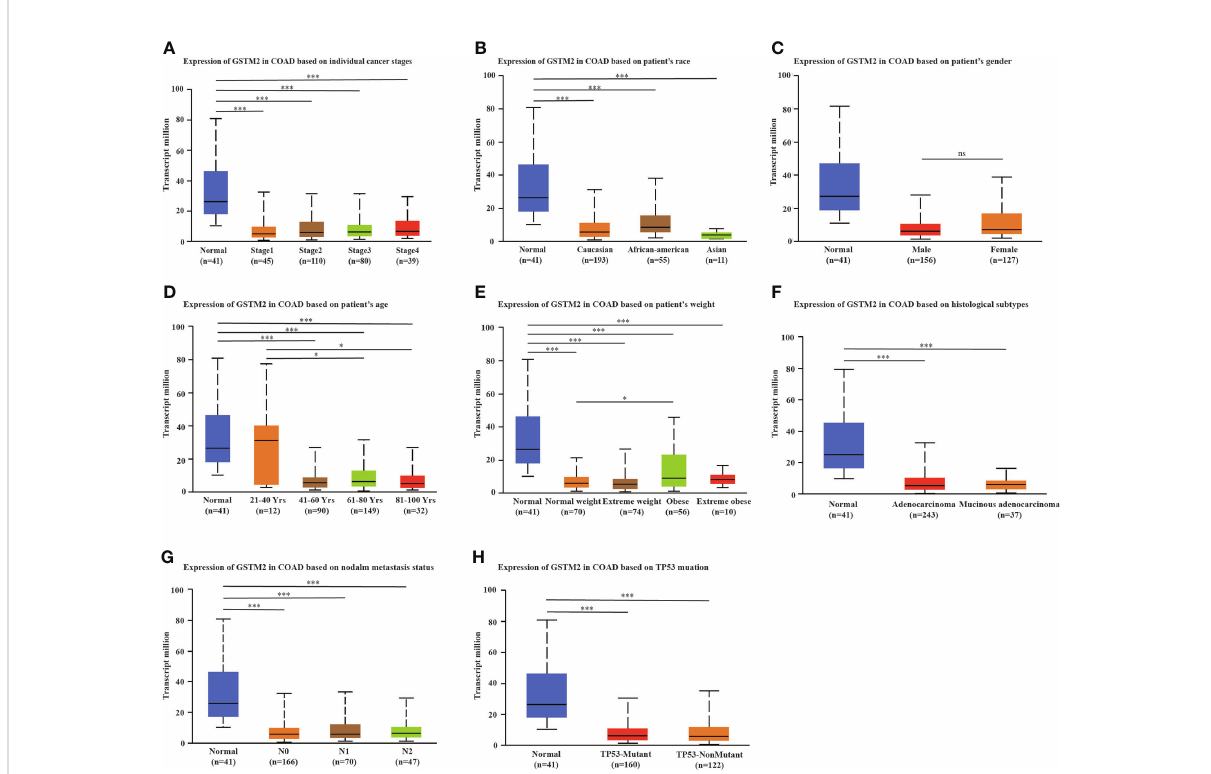
FIGURE 2 The Correlation between the GSTM2 Expression and Various Clinical Features. Analysis revealed the correlation between GSTM2 expression and (A) tumor stages, (B) race, (C) gender, (D) age, (E) weight, (F) histological subtypes, (G) metastasis, and (H) TP53 mutation. N0 indicated no regional lymph node metastasis, N1 indicated 1 to 3 axillary lymph node metastasis, N2 indicated 4 to 9 cases of axillary lymph node metastasis. ns: not statistically signi fi cant, *p < 0.05, and ***p <